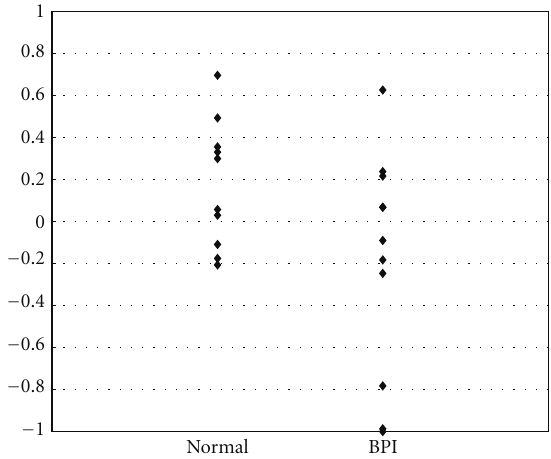
Figure 1: AI (asymmetry index) at the first fMRI of patients with right side BPI (brachial plexus injury) as compared with normal subjects.